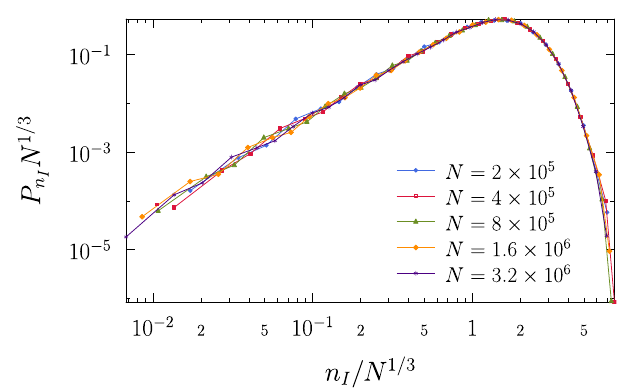
Figure 3. Distributions of loop lengths for different system sizes. Scaling plot of the probability P generation n I at which a loop is formed in critical branching processes on ER networks. Data for different system sizes are well collapsed onto a single curve with the scaling form of P N are obtained from ER network with mean degree z = 8 far away from the transition point z c =